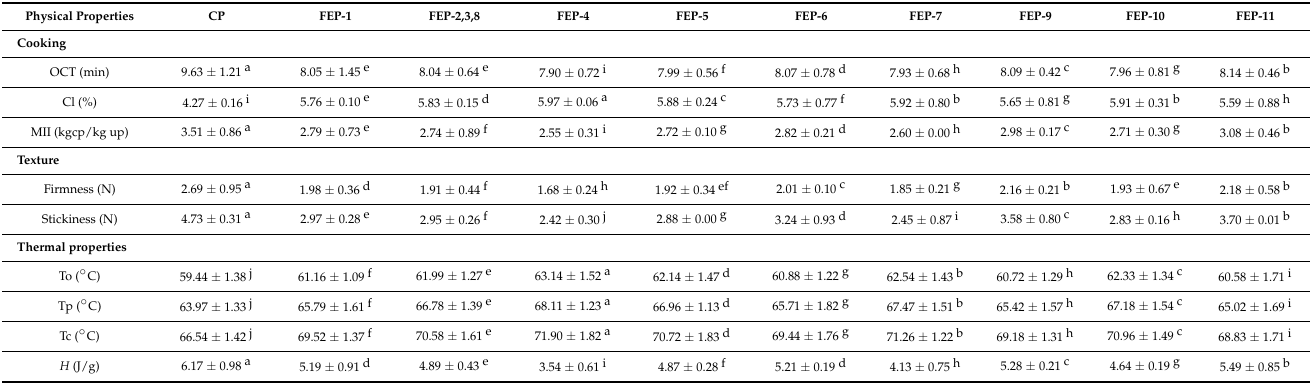
Table 4. Physical properties (cooking, texture, thermal) of fiber-enriched pasta